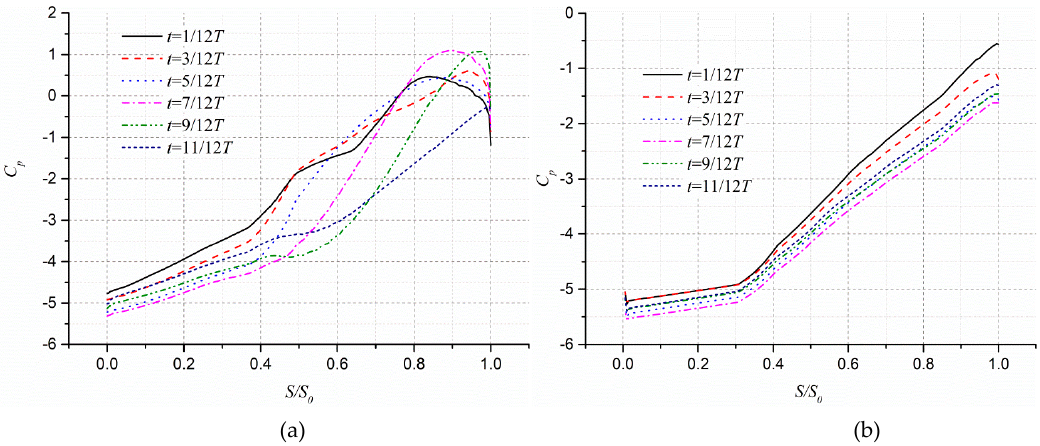
Figure 5. Distribution of pressure coefficient on the blade surface for the Z / b 2 = 0.15 cross section: ( a ) pressure surface and ( b ) suction surface.